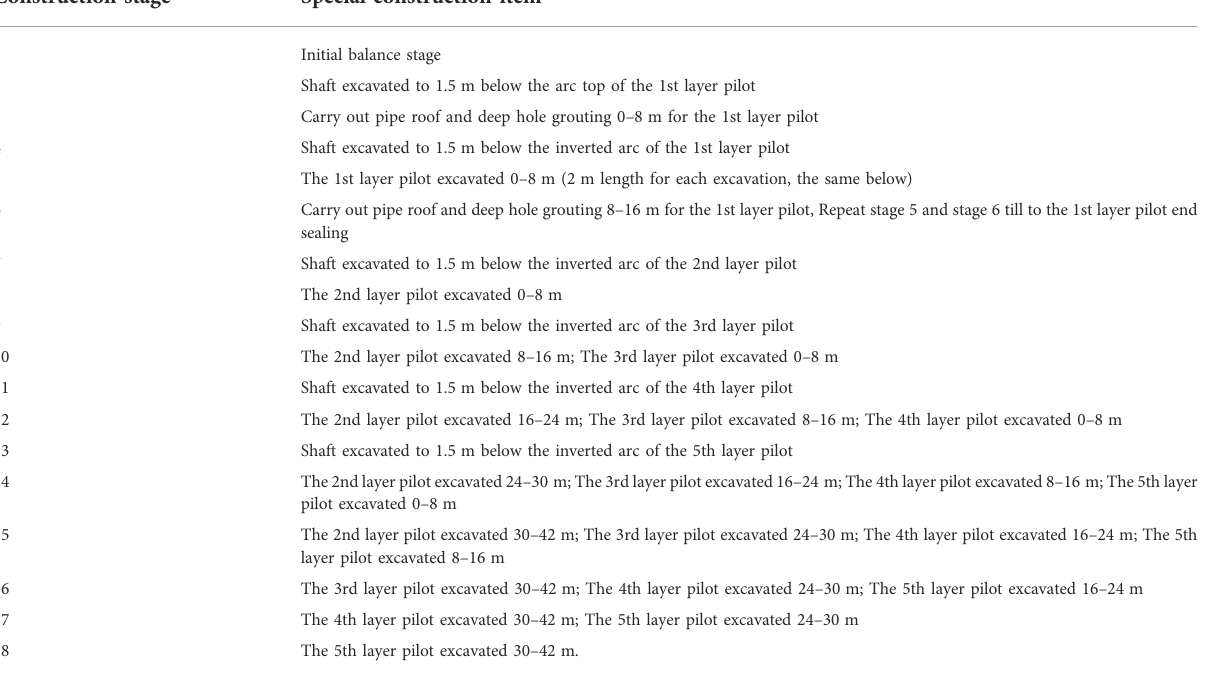
TABLE 6 Construction procedures in numerical